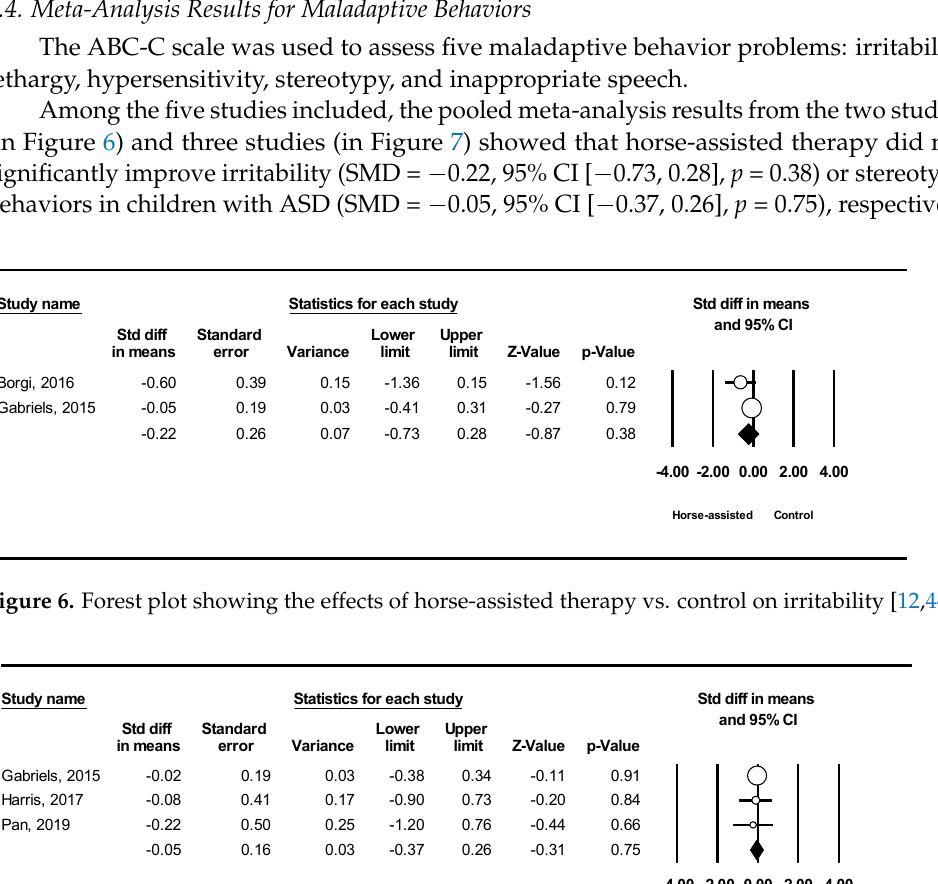
Figure 5. Forest plot showing the effects of horse-assisted therapy vs. control on social motivation [31,43,44,46].